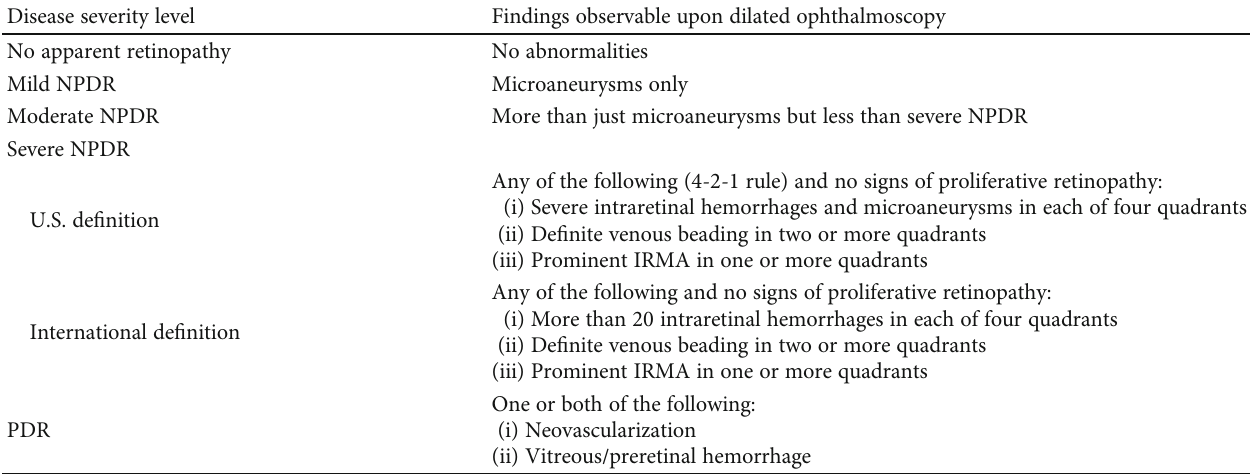
Table 2: The Diabetic Retinopathy Disease Severity and International Clinical Diabetic Retinopathy Disease Severity Scales. Disease severity level Findings observable upon dilated ophthalmoscopy